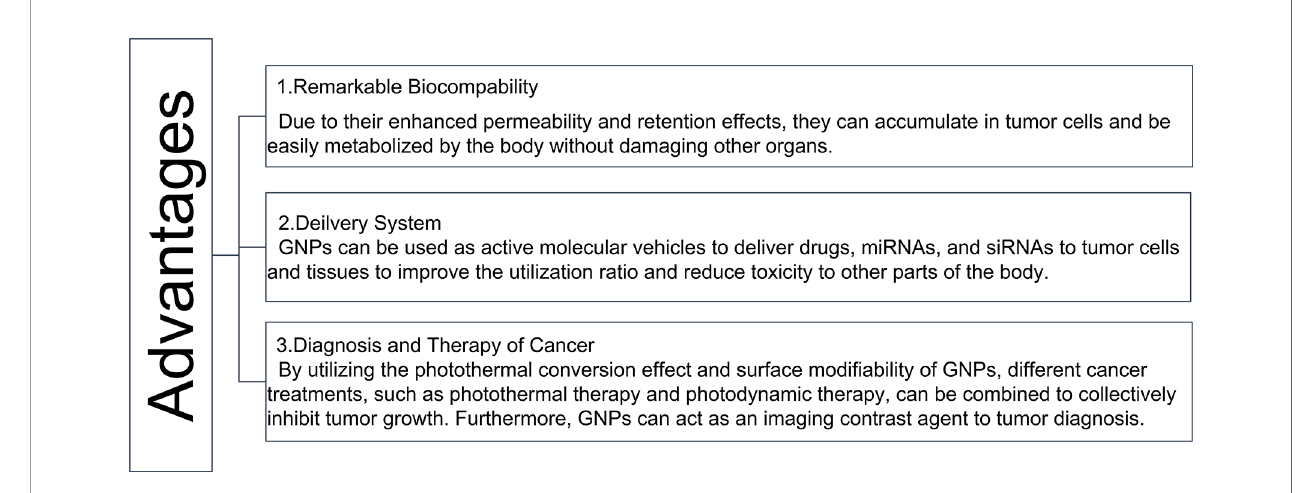
FIGURE 6 | The advantages of GNPs in cancer